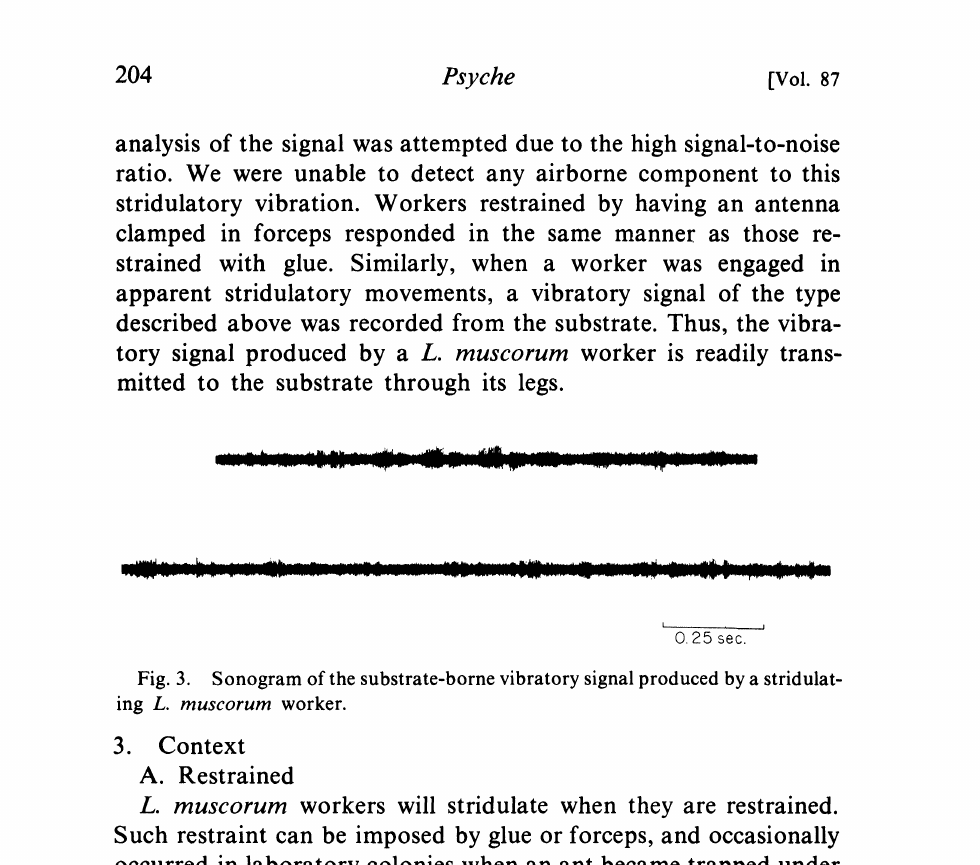
Fig. 3. Sonogram of the substrate-borne vibratory signal produced by a stridulat- ing L. muscorum